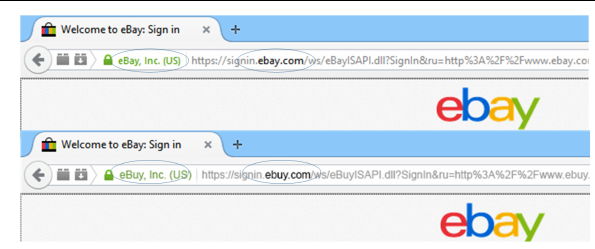
FIGURE 1 | Example website manipulations. The top image depicts a legitimate website, with both a valid URL in bold and extended validation (EV) certificate in green text. The bottom image depicts a sample spoof website with modified URL and EV certificate (Kelley and Bertenthal,